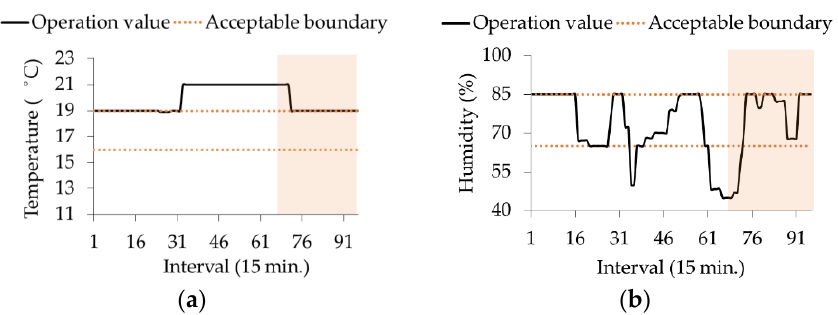
( b ) Humidity. Figure 15. Environmental control of a building microgrid with rooftop greenhouse: ( a ) Temperature;